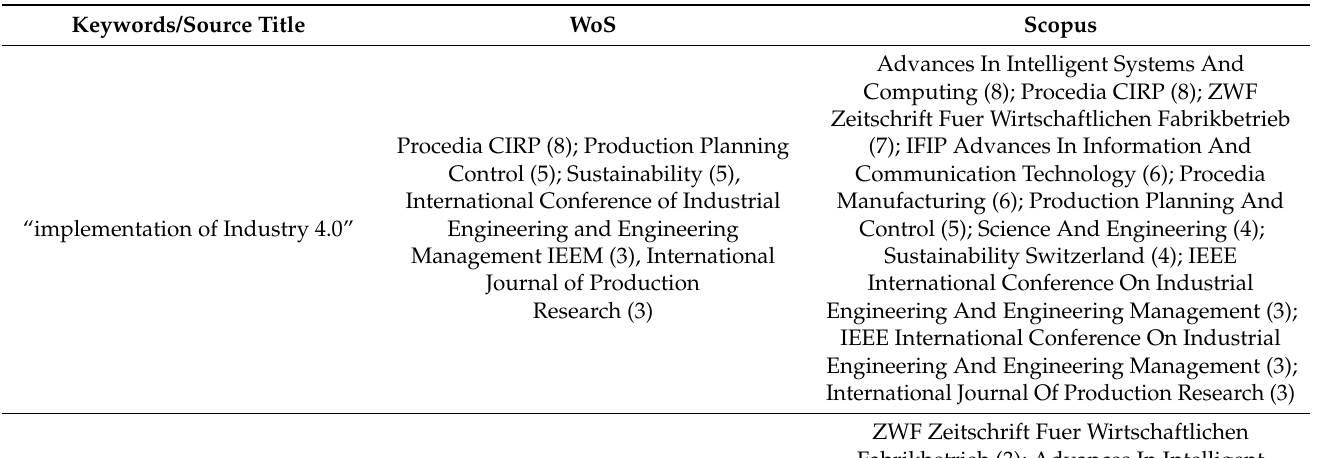
Table 7. Results of own literature review in the field source